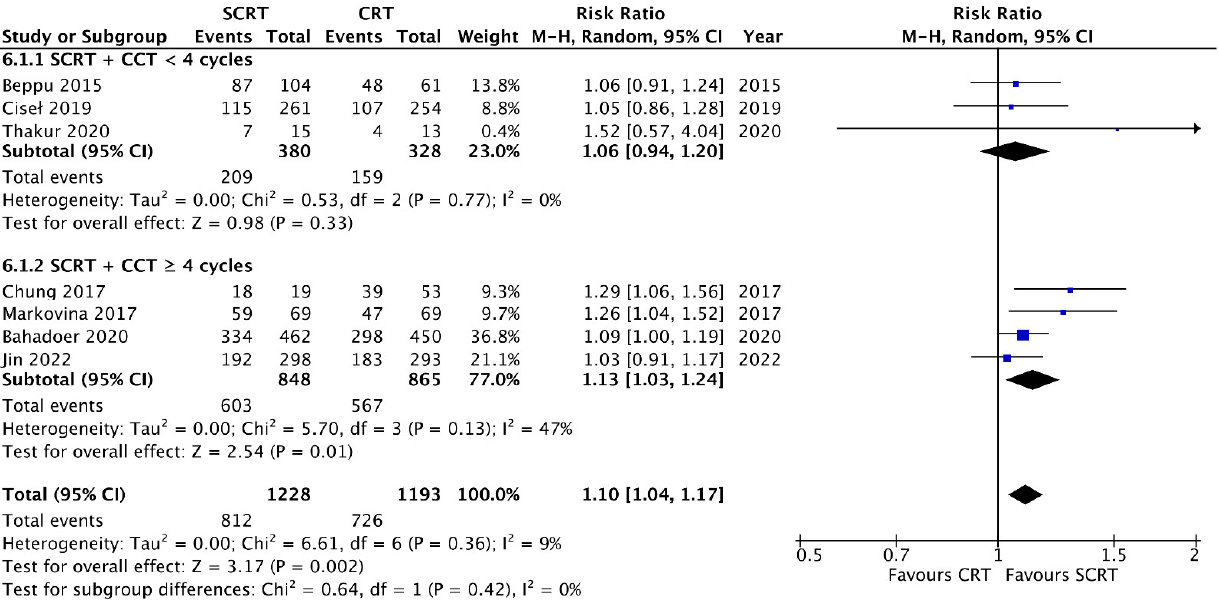
Figure 11. Forest plot for subgroup analysis of the disease free survival (DFS) events according to consolidation chemotherapy cycles.